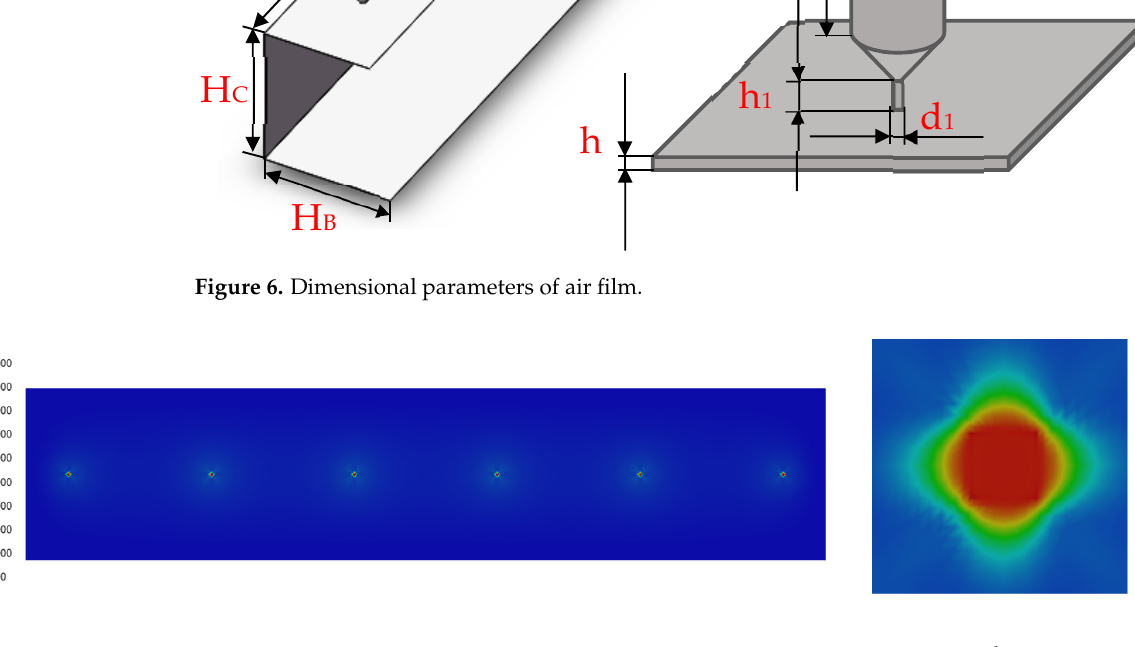
Figure 7. ( a ) Pressure distribution on a balanced surface of an air film (0.5 MPa). ( b ) Pressure distribution near the throttle hole.